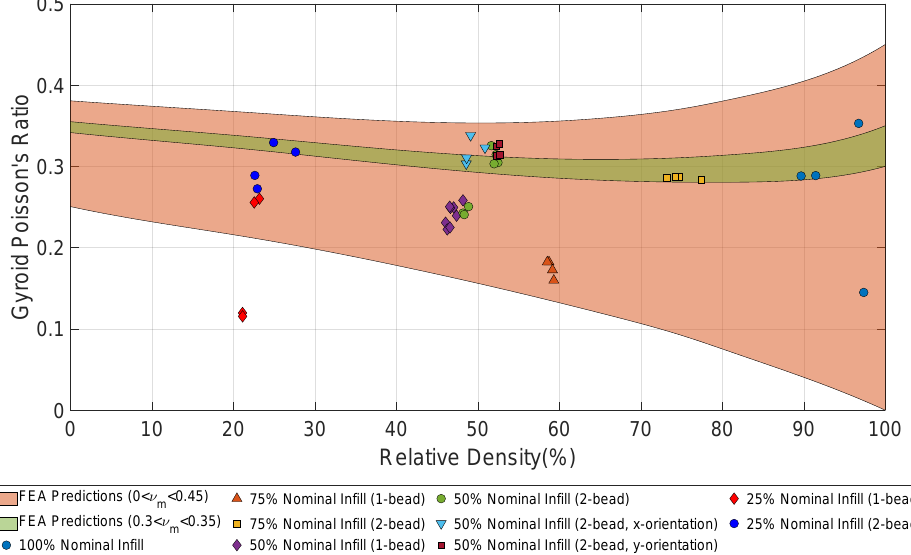
Figure 12. Experimental results vs. FEA predictions for Poisson’s